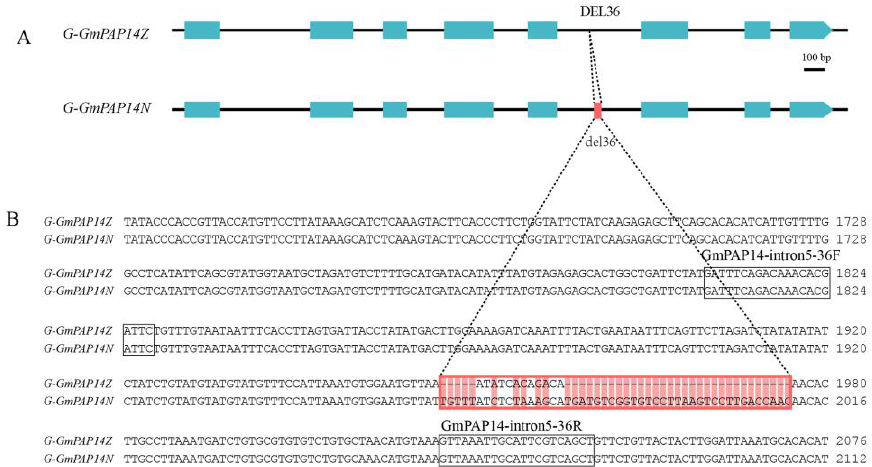
Figure 3. The structural analysis of GmPAP14 gDNA in zhonghuang (ZH15) and niumaohuang (NMH). (A) The structure of GmPAP14 gDNA. G-GmPAP14Z represents GmPAP14 gDNA in ZH15 and G-GmPAP14N represents GmPAP14 gDNA in NMH. The blue box represents exons and the black polylines represent introns. The red box represents differences in the two sequences. The marker GmPAP14-intron5-36F/R was designed according to the 36-bp variation, and was used for genotyping GmPAP14 in soybean